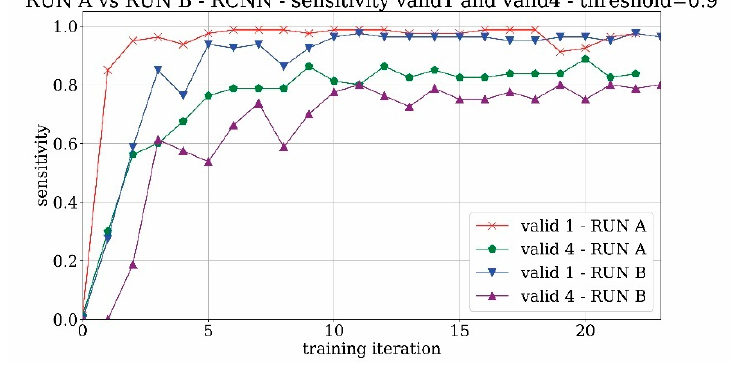
Figure 10. Sensitivity trend of RUN A and RUN B with valid 1 and 4, and threshold 0.9.